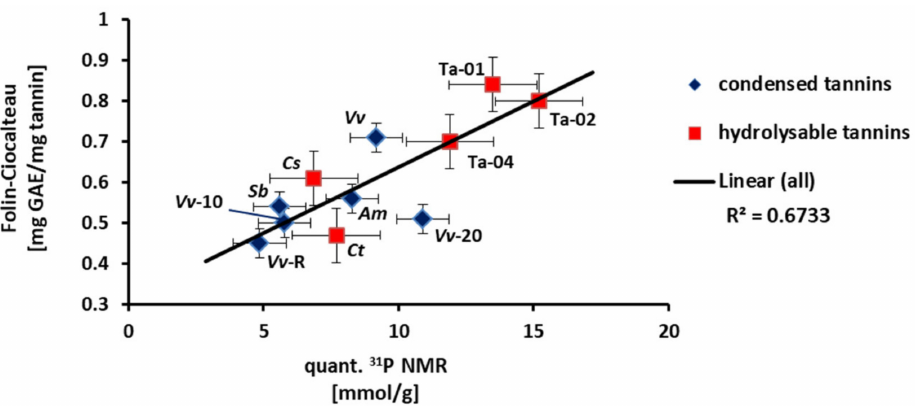
Figure 5. Correlation between the results obtained for the total phenol content by means of quantita- tive 31 P NMR and the Folin–Ciocalteau